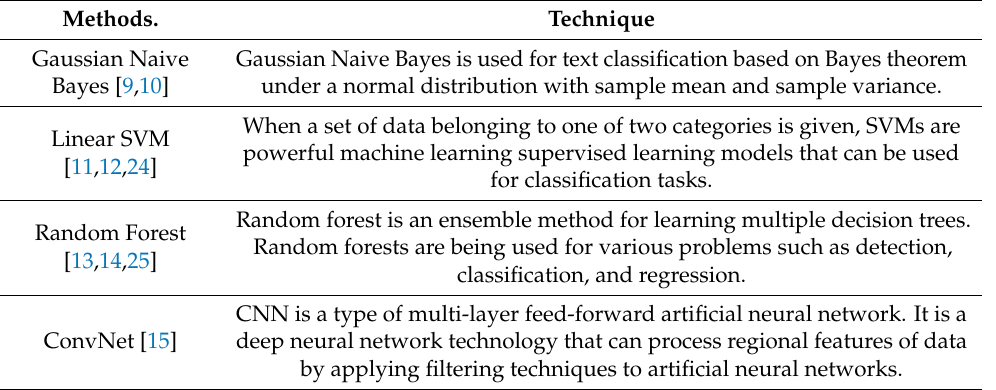
Table 1. Summary of methods for text classification.